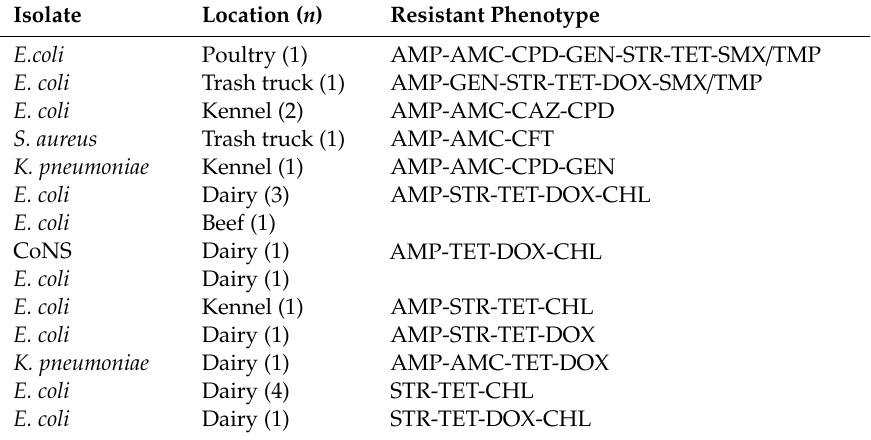
Table 4. Antimicrobial resistance pattern in multidrug and ESBL-resistant isolates.